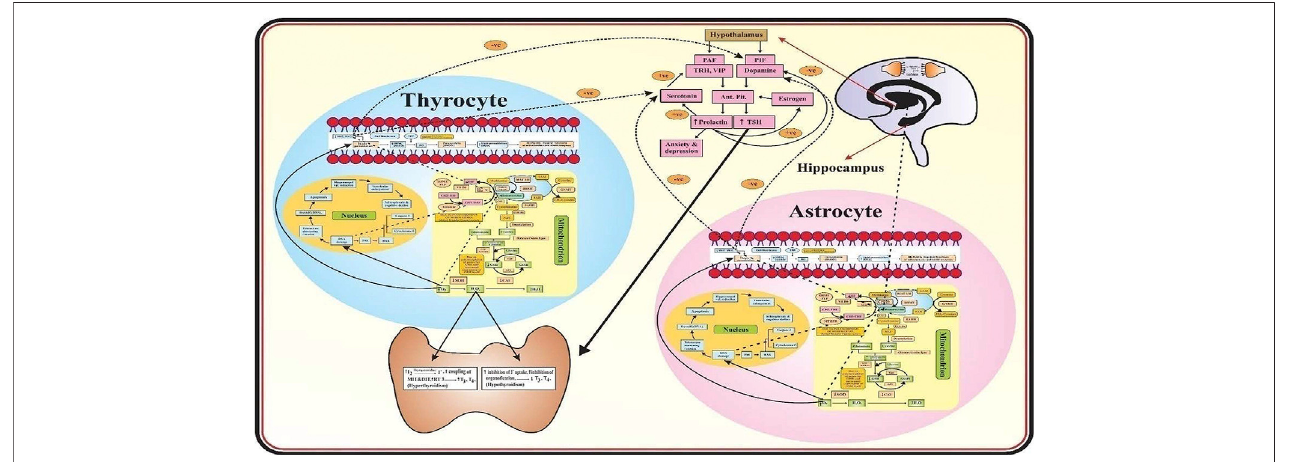
FIGURE 1 | Mechanism of Thyroid Dysfunction in Schizophrenics. The role of oxidative stress and the biomarkers associated with thyroid dysfunction in